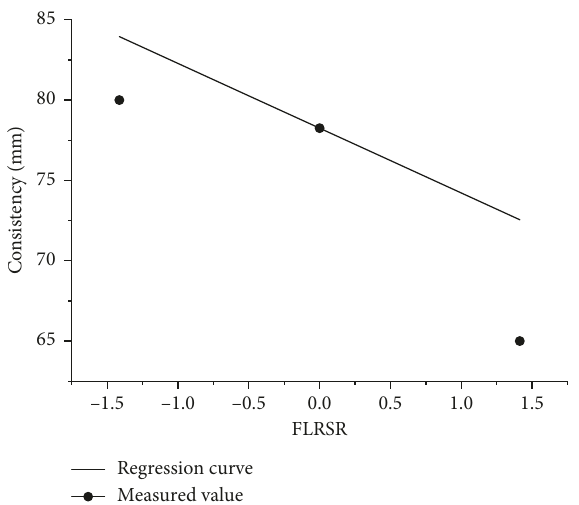
Figure 9: Influence of rubber on consistency when the level of cellulose ether is 0.